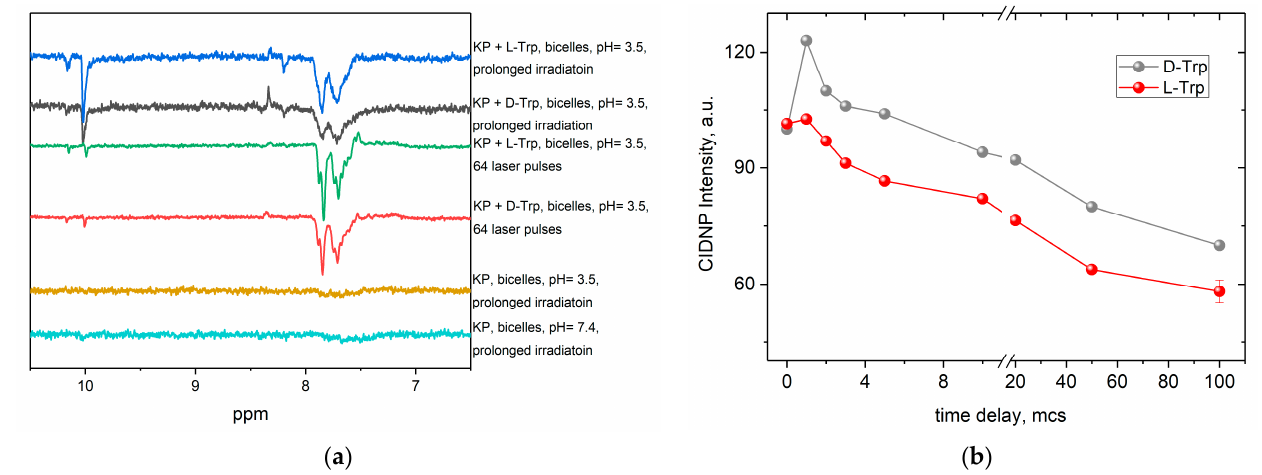
Figure 5. CIDNP spectra detected during photolysis of 2 mM S-KP in the absence and in the presence of 4 mM L/D-Trp in DHPC/DMPC bicelles at pH = 3.5 at pH = 7.4 ( a ); kinetics of TR CIDNP intensity of KP protons (7.8 ppm) at pH 3.5 ( b ).